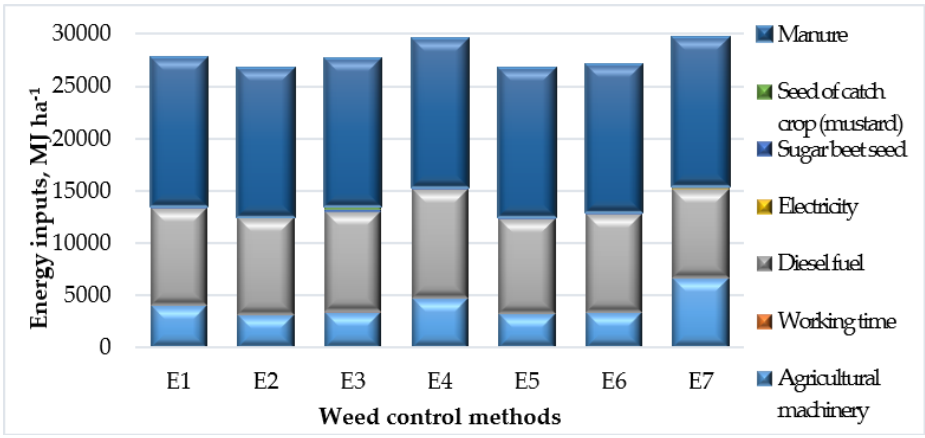
Figure 4. The impact of weed control methods on the energy consumption of organic sugar beet production.